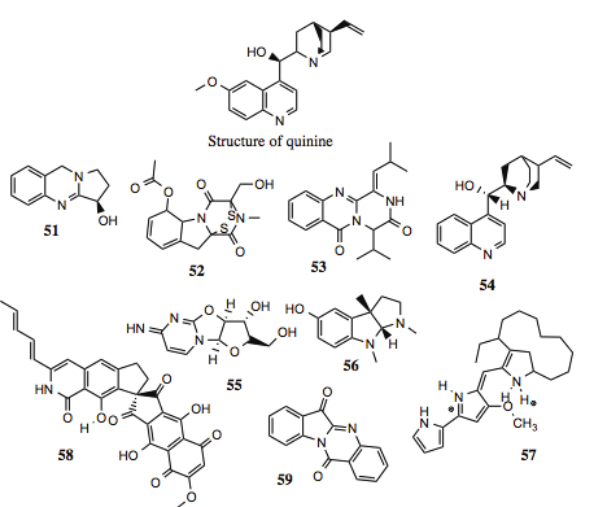
Figure 7. Alkaloid